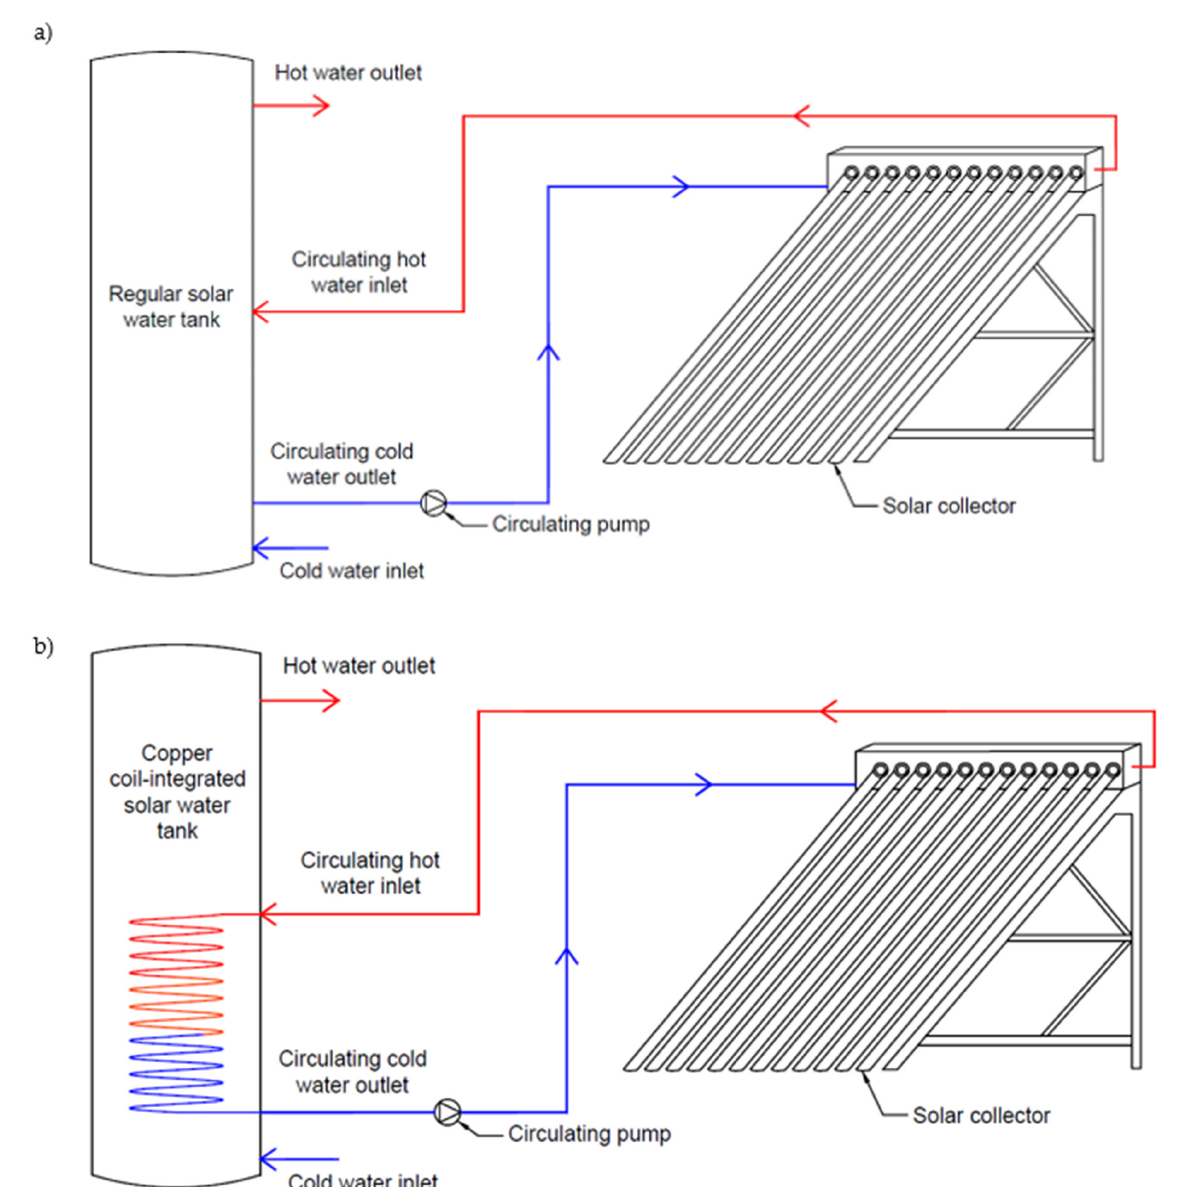
Figure 8. Indirect, split design with ( a ) regular water tank and ( b ) copper coil-integrated water tank for ETC solar water heaters [58].